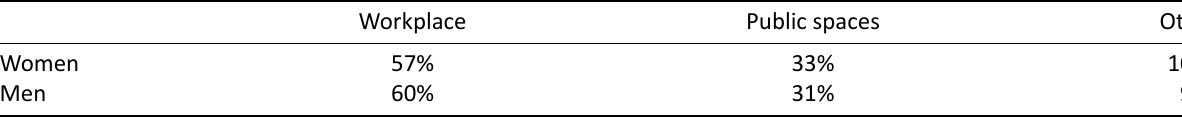
Table 2. Spaces of discrimination by gender (qualitative data). Workplace